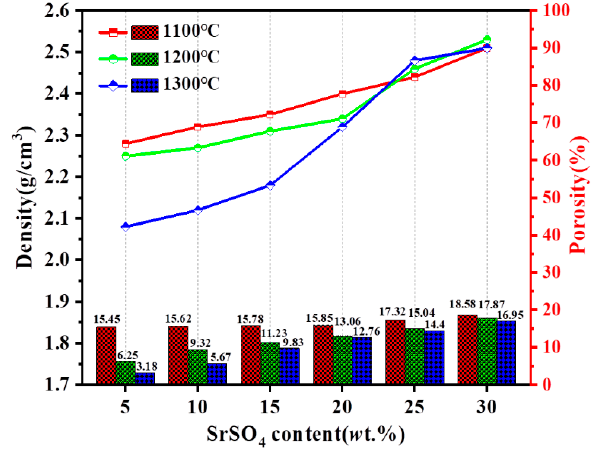
Figure 8. Density and porosity of the typical samples sintered at various temperature.